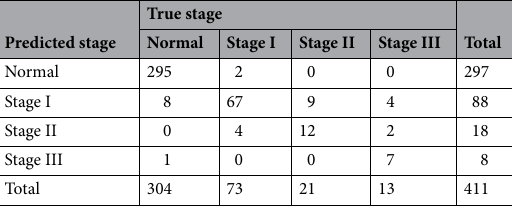
Table 2. Staging prediction results in the test